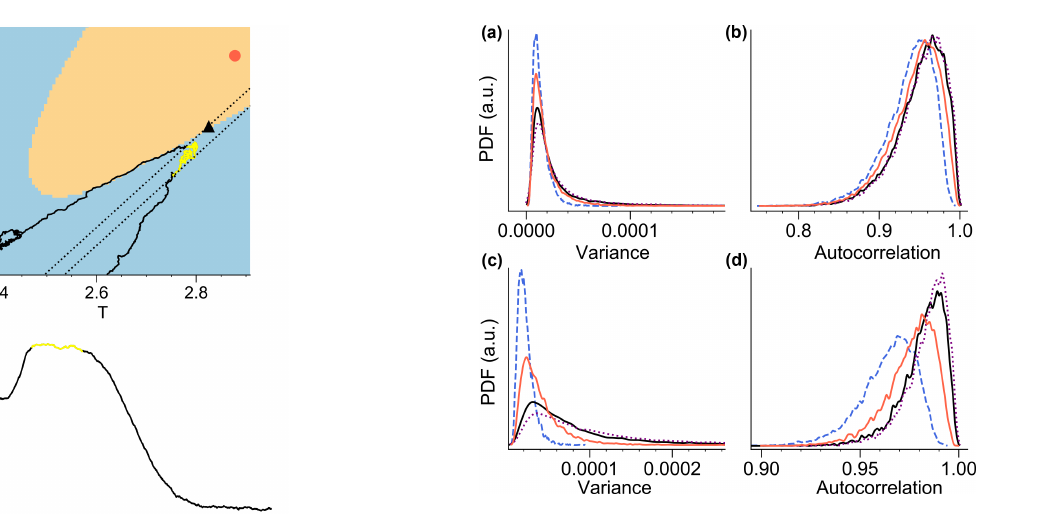
Figure 14. Distributions of variance and autocorrelation for ensem- bles of time series from the Stommel model ( σ T = σ S = 0 . 2). These are estimated from time series segments around the initial fixed point at η 1 = 2 . 65 (black) and close to the saddle point (orange; see main text). The length of the segments for each realization cor- responds to the time period that the system spent in the vicinity of the saddle. (a, b) Results for realizations where these time windows were at least 300 years long. (c, d) Results for time windows of at least 700 years. Also shown are the distributions around the on attractor (dashed) and the off attractor at η 1 = 3 . 0